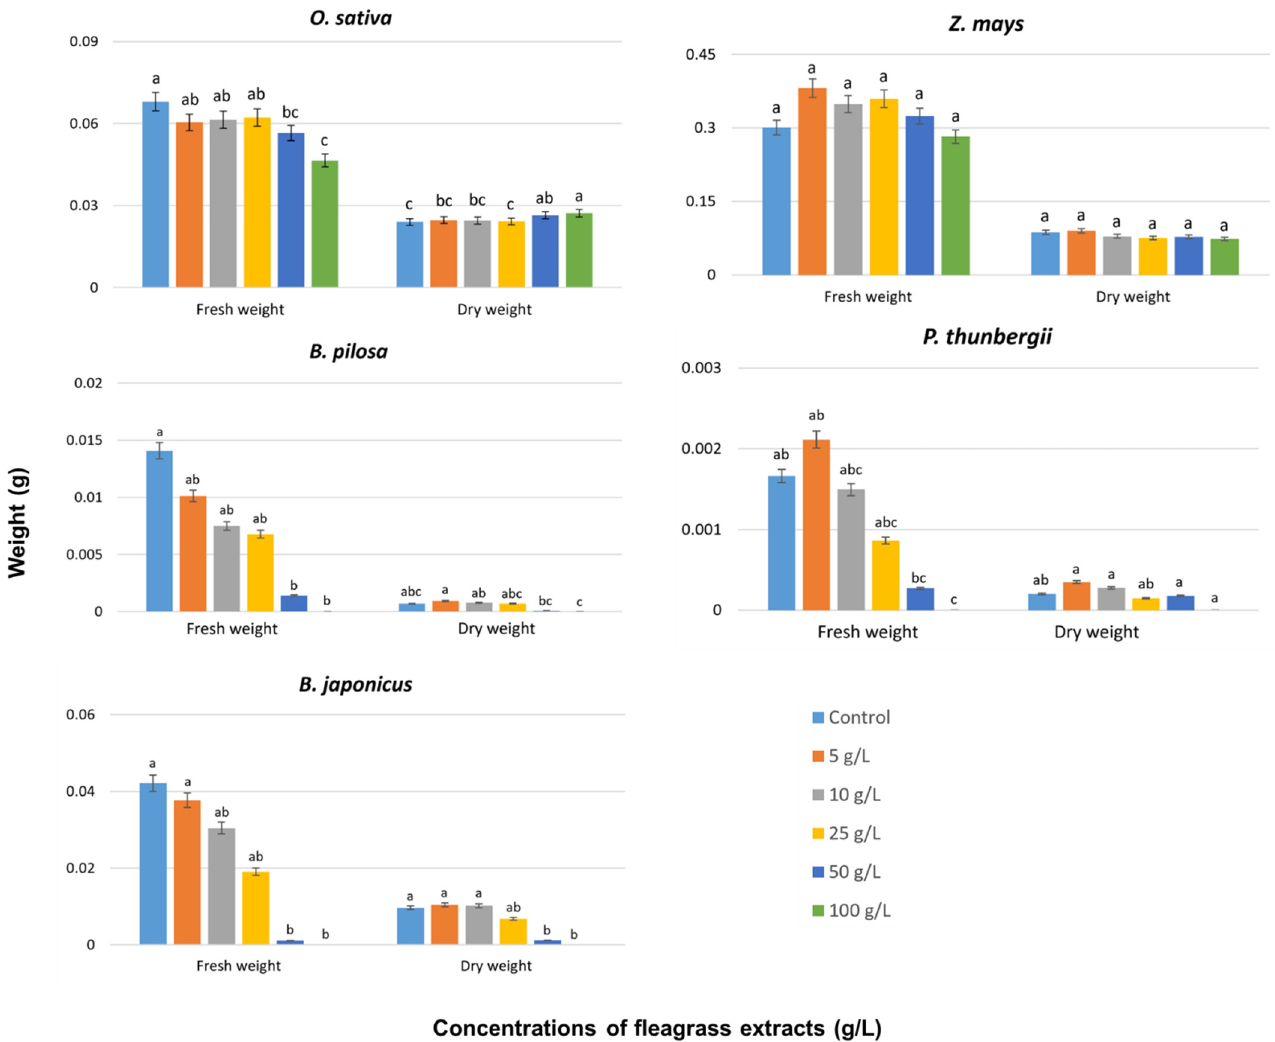
Figure 2. Effects of fleagrass extracts on the fresh and dry weight of five target plants; significant differences (one-way ANOVA, LSD-test) are marked using different letters.